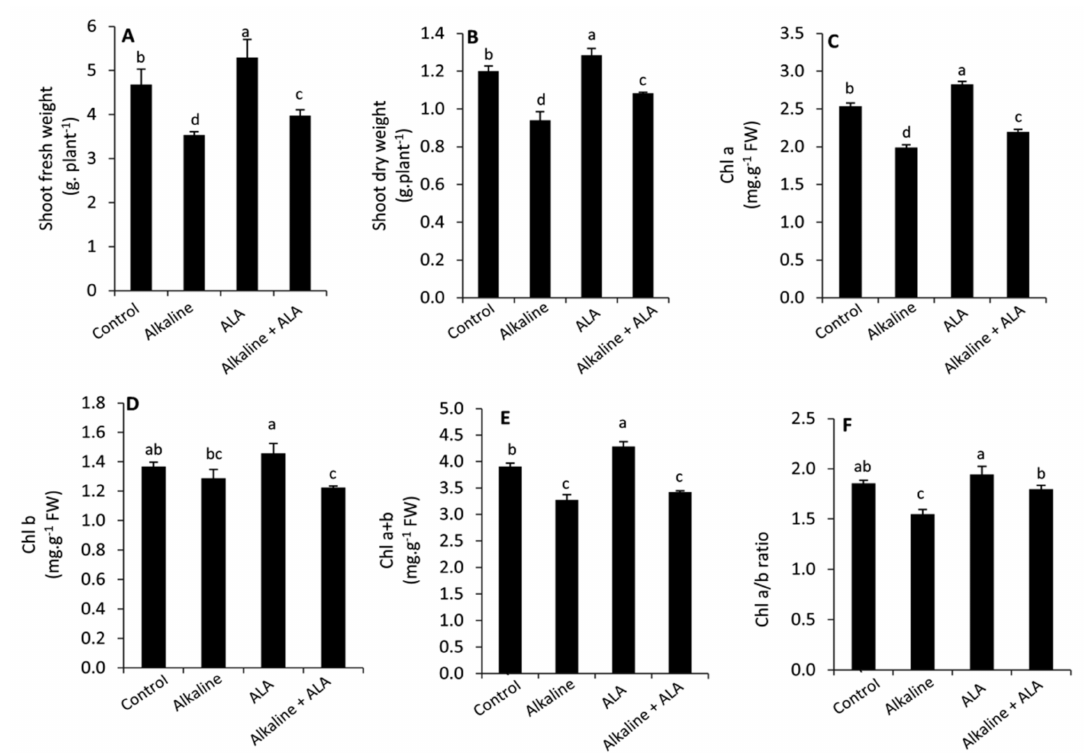
Figure 1. Effect of exogenous α -lipoic acid (ALA; 20 µ M) on shoot fresh weight ( A ), shoot dry weight ( B ), Chl a ( C ), Chl b ( D ), Chl a + b ( E ) and Chl a/b ratio ( F ) of wheat seedlings grown under sodic alkaline stress. Chl, chlorophyll.